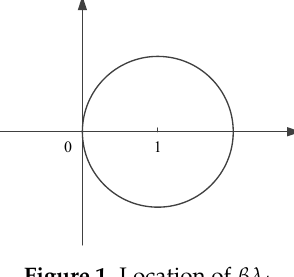
Figure 1. Location of βλ i